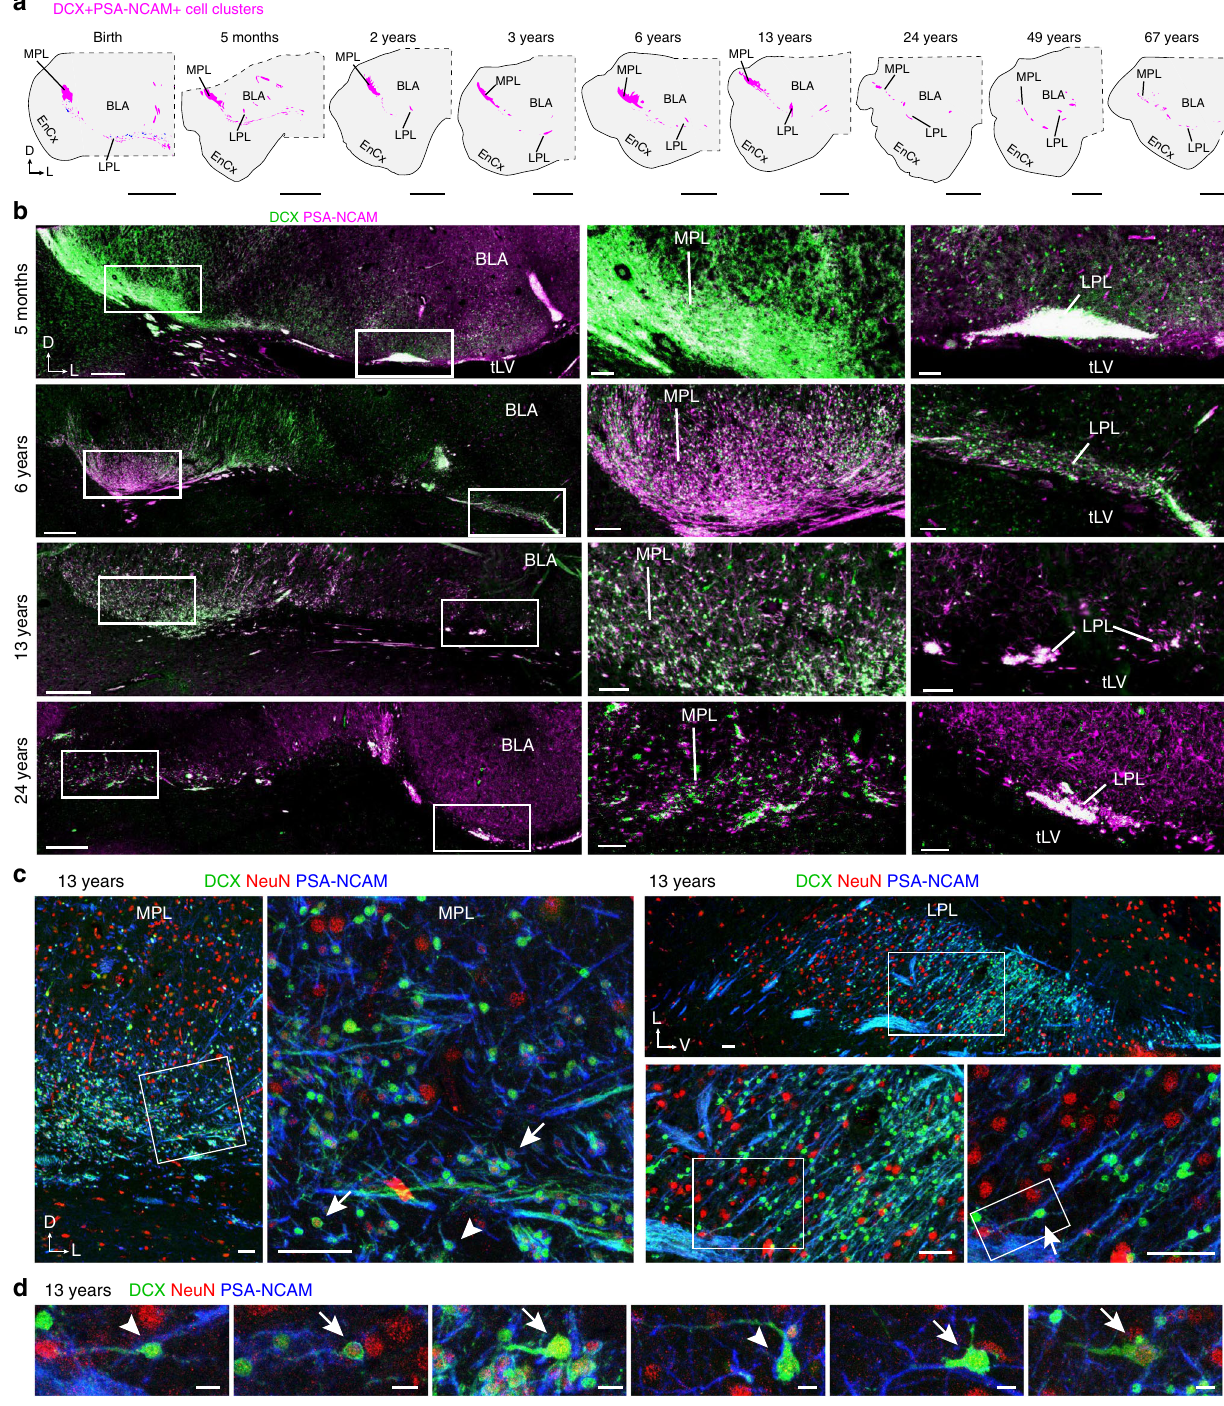
Fig. 3 Postnatal maturation of DCX + PSA-NCAM + neurons in the PL. a Maps of the location of DCX + PSA-NCAM + cells in the PL from birth to 67 years of age, at approximately the same rostrocaudal level. b DCX + PSA-NCAM + cells in the PL from 5 months to 24 years in coronal sections. (Right) Higher magni fi cation of DCX + PSA-NCAM + cells in the MPL and LPL. c DCX + PSA-NCAM + NeuN + neurons in the 13-year-old MPL (Left) and LPL (Right). Some cells had the shape of migratory neurons (arrow). d Examples of DCX + PSA-NCAM + cells that are NeuN + (arrows) and NeuN – (arrowheads) in the MPL at 13 years of age. Scale bars: 5 mm ( a ), 500 µ m ( b left), 100 µ m ( b middle and right), 50 µ m ( c ), 10 µ m ( d